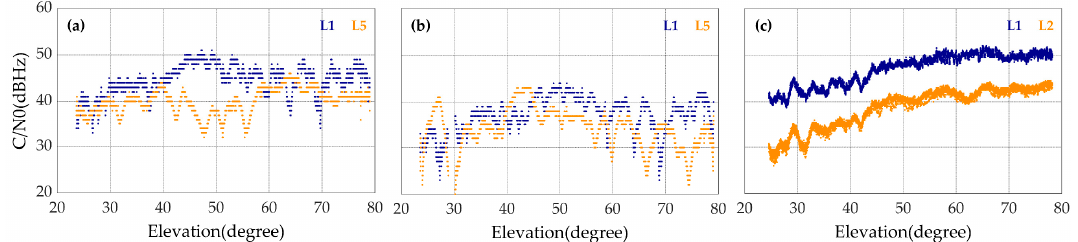
Figure 7. The carrier-to-noise ratios of L1 (blue), L5 or L2 (orange) code measurements of G26 satellite with the Mate30 ( a ), the V20 ( b ) and the Trimble R8 ( c ) with respect to the satellite elevation in the first experiment.